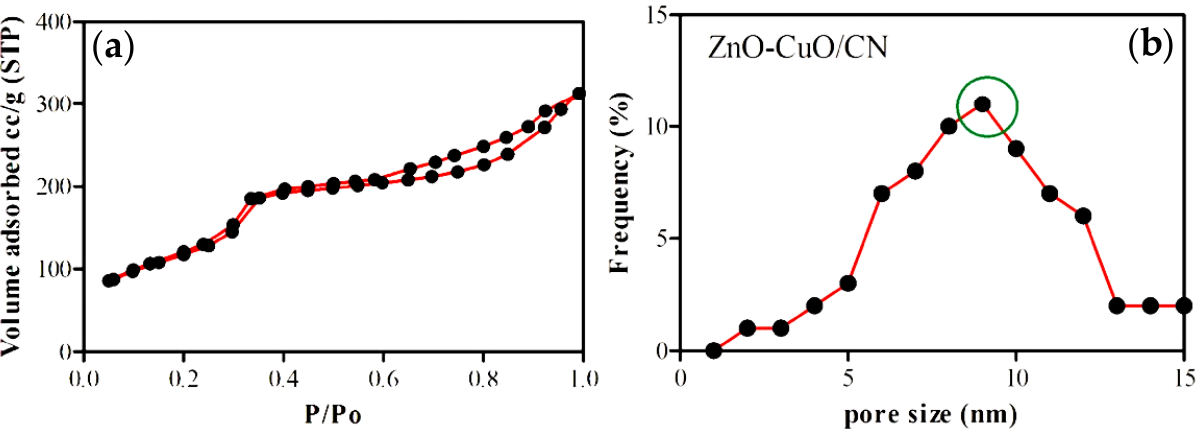
Figure 4. ( a ) N 2 adsorption-desorption isotherm curves of the synthesized ZnO–CuO/g–C 3 N 4 and ( b ) their pore size distribution.